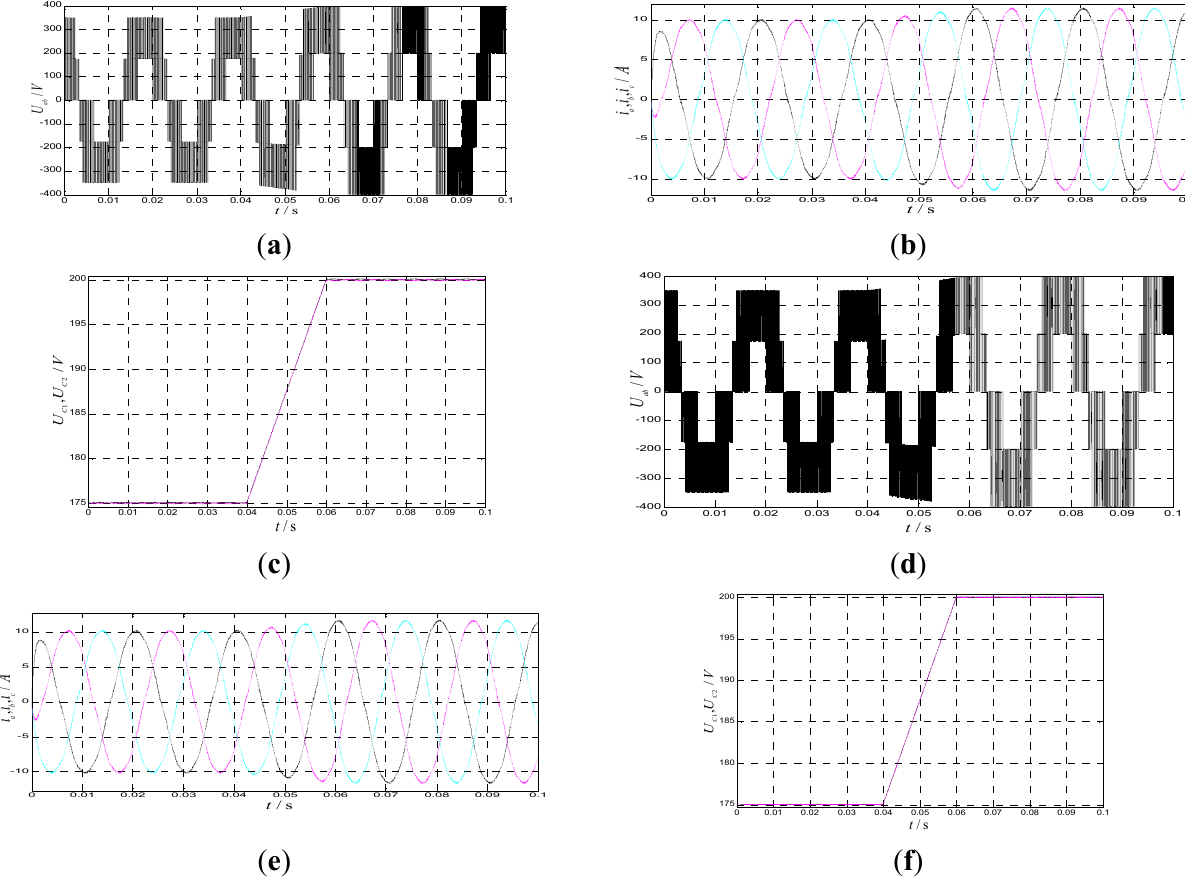
Figure 5. Simulation results of varying DC-link capacitors voltage; ( a ) varying process of line-to-line voltage in VSVM; ( b ) three phase currents in VSVM; ( c ) varying process of DC-link capacitors voltage in VSVM; ( d ) varying process of line-to-line voltage in VVSVM; ( e ) three phase currents in VVSVM; ( f ) varying process of DC-link capacitors voltage in